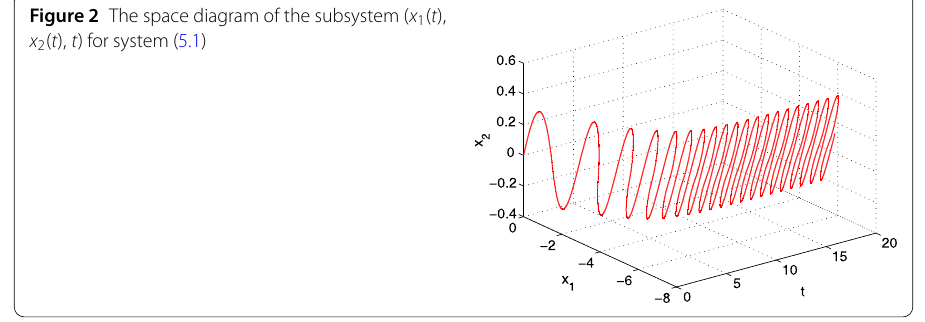
Figure 2 The space diagram of the subsystem ( x 1 ( t ), x 2 ( t ), t ) for system (5.1)